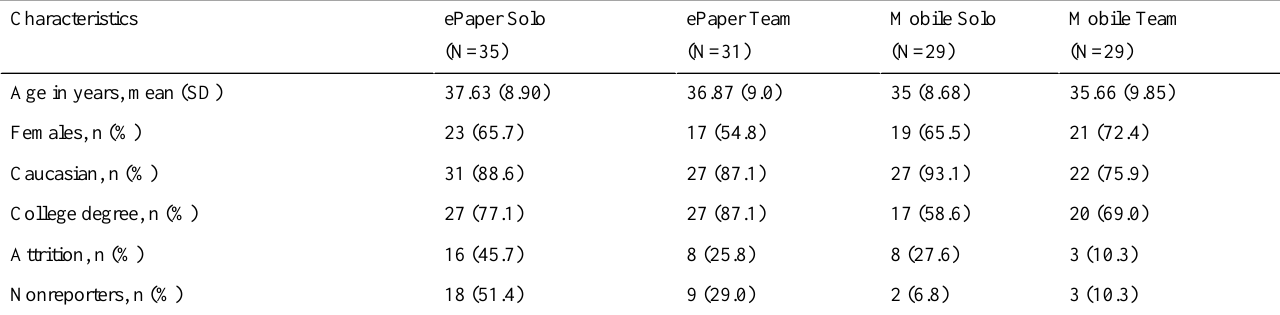
Table 1. Characteristics of the participants by conditions.